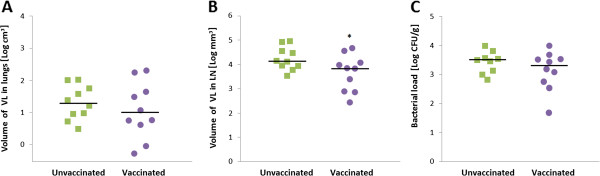
Post-mortem analysis as measured by gross pathology and bacterial burden. Results are plotted for individual goats. (A) Total volume of visible lesions (VL) in lungs as log10 cm3. (B) Total volume of VL in respiratory lymph nodes (LN) as log10 mm3. (C) Bacterial load as log10 cfu/g. (●) vaccinated goats, (■) unvaccinated goats. Horizontal lines indicate median values. Significance determined by unpaired t-test: *p < 0.05.